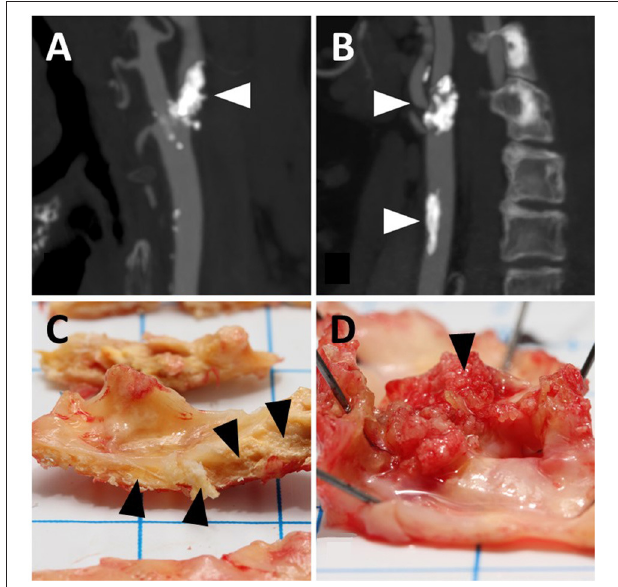
FIGURE 1 | Representative illustrations of calcification in angiograms (A,B) and carotid endarterectomy samples for macroscopic observation (C,D) . (A) Shows calcification of the internal carotid artery (arrowhead); (B) shows that calcification is present in the internal (upper arrowhead) as well as the common carotid artery (lower arrowhead). (C) shows intramural calcification (arrowheads); (D) shows luminal calcification (arrowhead). the angiograms and endarterectomy samples do not refer to the same